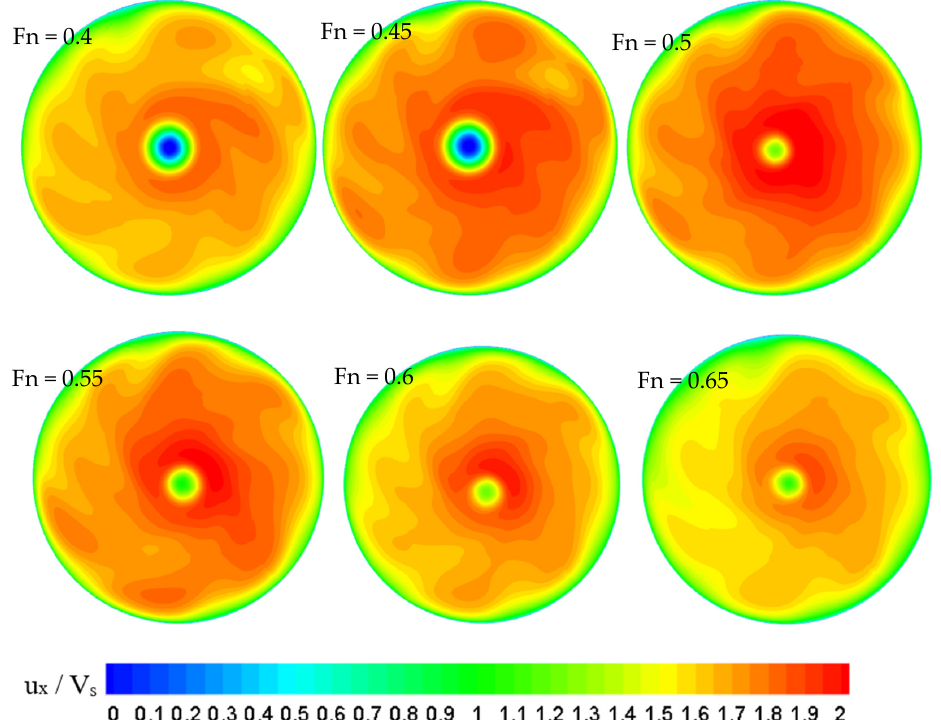
Figure 28. The axial velocity (u x /V s ) distribution on the nozzle section.